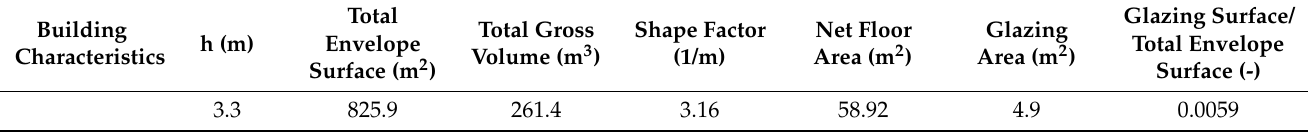
Table 2. Geometrical data of the rammed earth case study